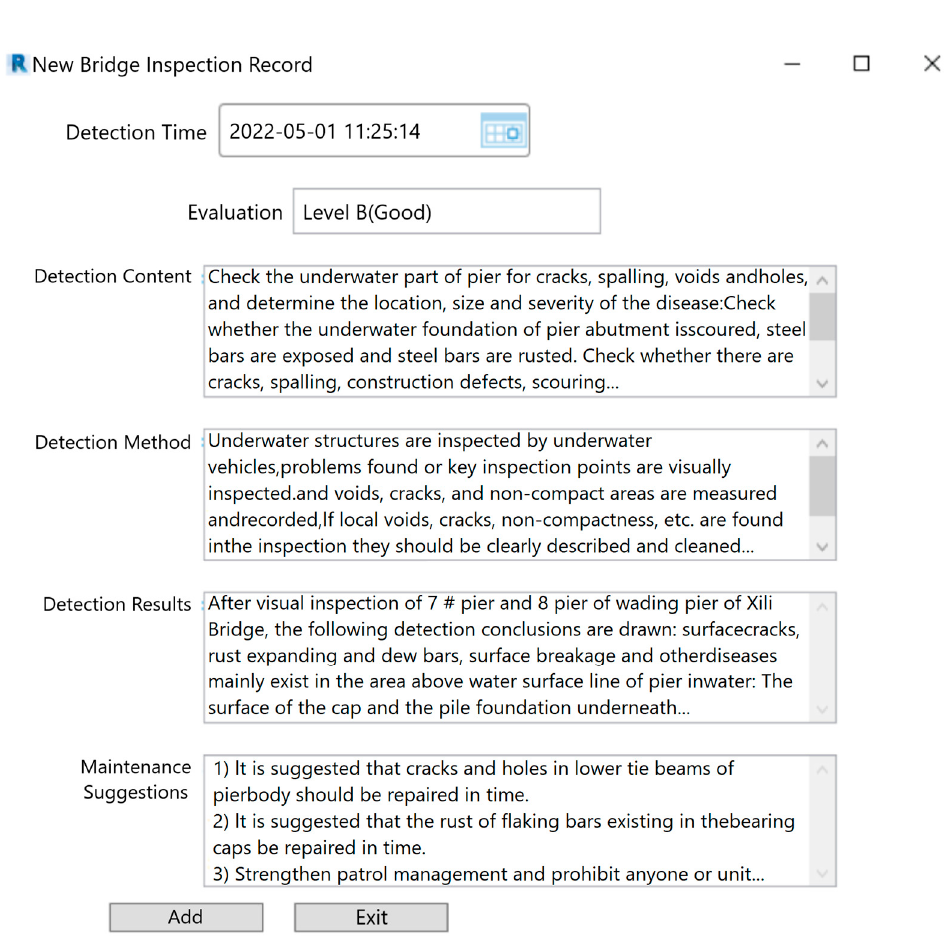
Figure 16. Graph Check Record Table.